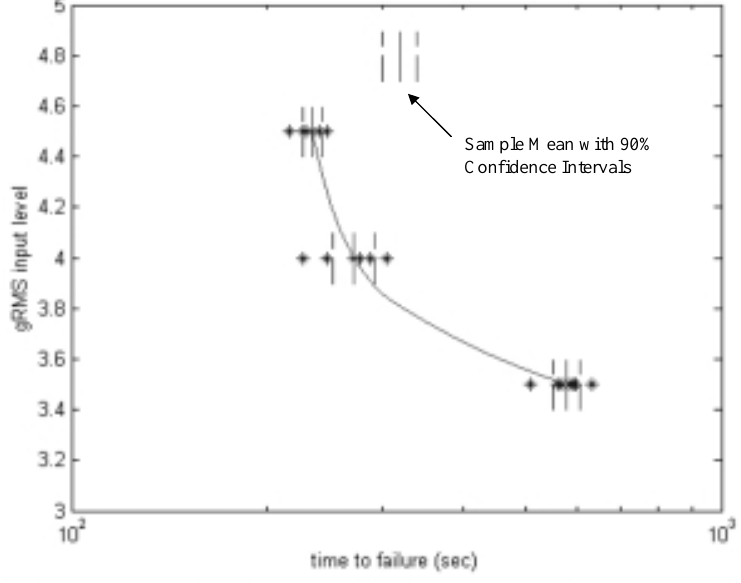
Fig. 8. Uniaxial results for excitation in the transverse direction only.